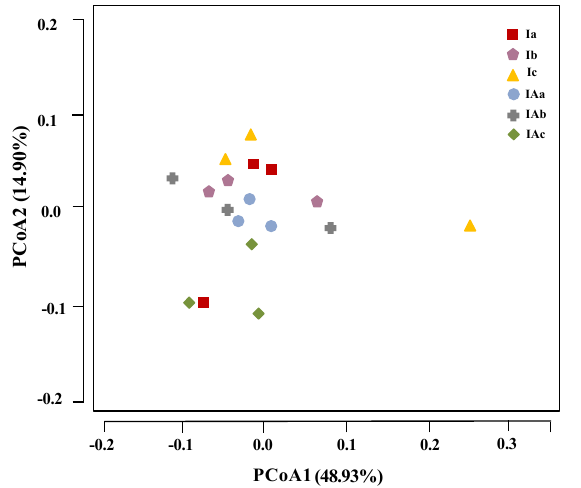
Figure 7. PCoA based on the weighted-UniFrac distance to the structures of bacterial communities at the different treatments.